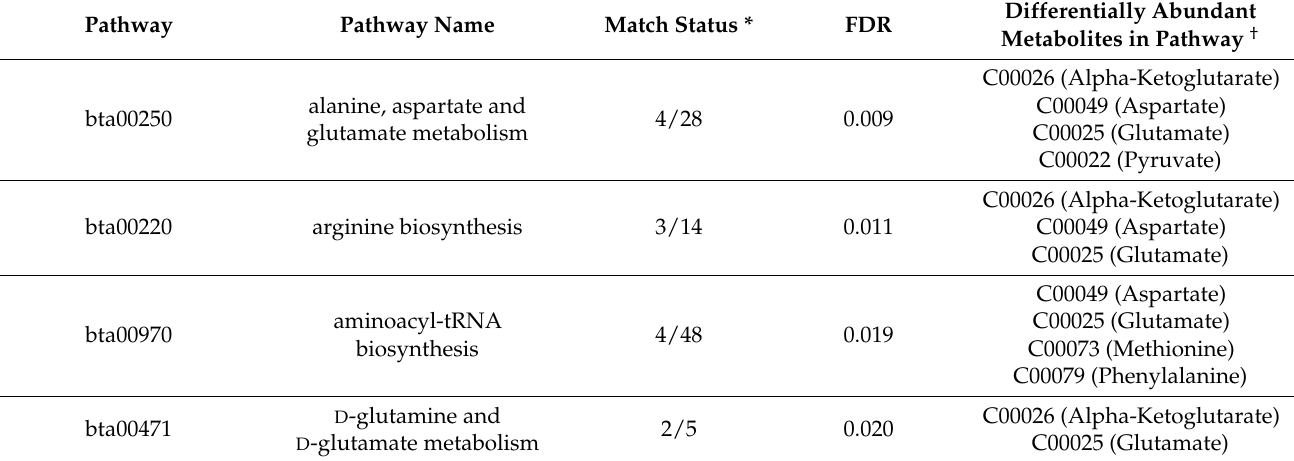
Table 1. KEGG pathways significantly enriched with metabolites that were significantly correlated with increasing pre- ovulatory follicle